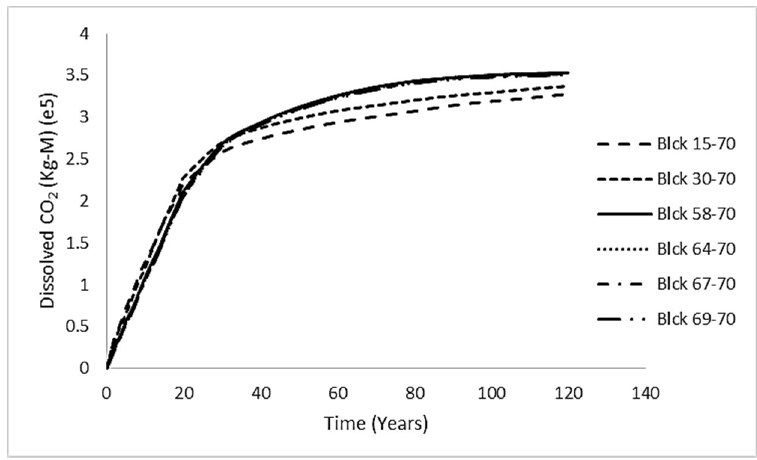
Figure 10. Simulation result for the effect of the number of grid block connections between well and reservoir.